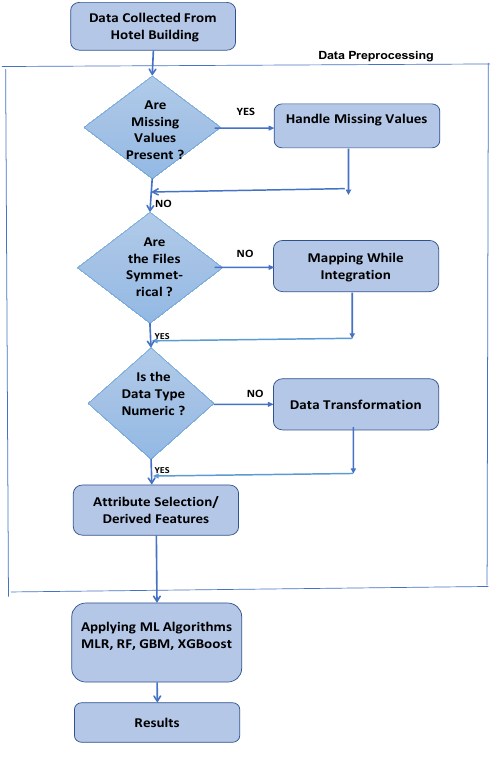
Figure 5 . Work Flow of the proposed methodology